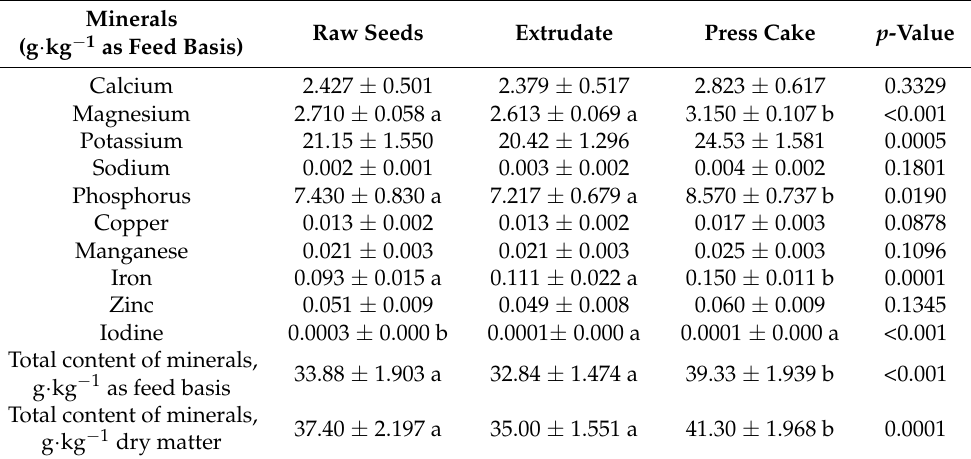
Table 8. The content of minerals in the raw soybean seeds and feed products and the reference to crude ash and dry matter (the mean values from 3 soybean varieties ±